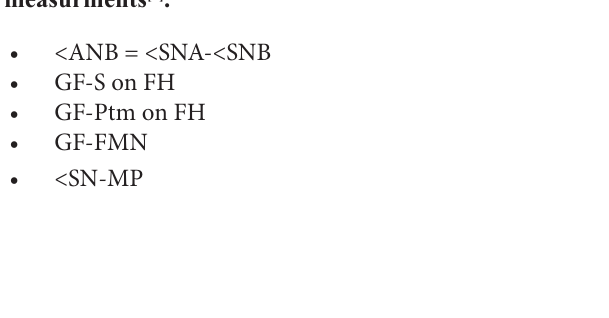
Figure-II: Cephalometric angular and linear measurments [7]